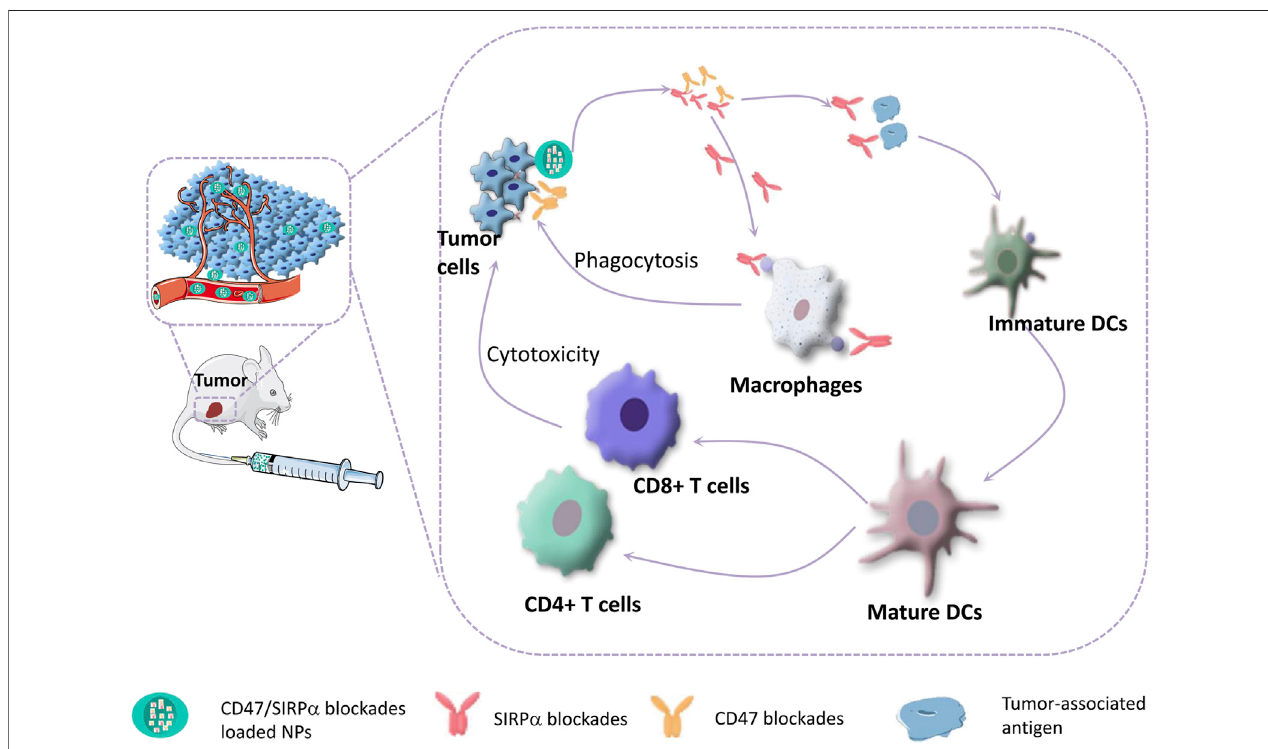
FIGURE 2 | CD47-SIRP α blockades can bridge innate and adaptive antitumor immunity. Blocking of CD47-SIRP α signaling axis can activate macrophages to phagocytize tumor cells, and promote the maturation of DCs, which enhances DC-mediated tumor-associated antigen presentation, thereby triggering T-cell mediated destruction of tumor